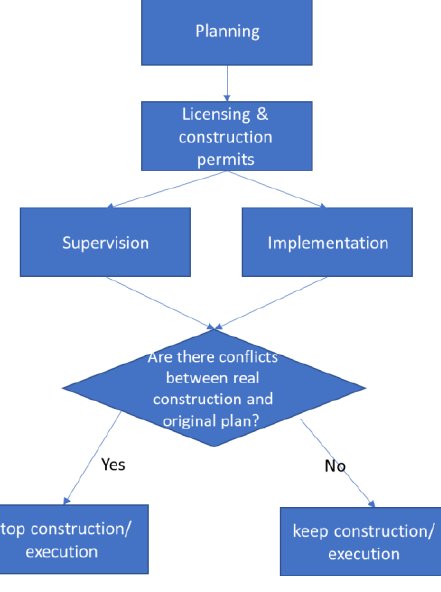
Figure 4. Conventional stages prior to construction involving